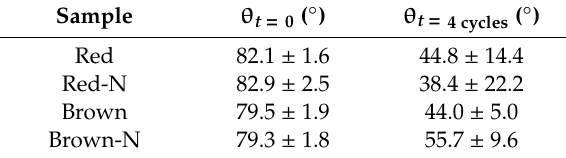
Table 7. Contact angle measurements ( θ ) at initial state ( t = 0) and after the fourth cycle ( t = 4 cycles).